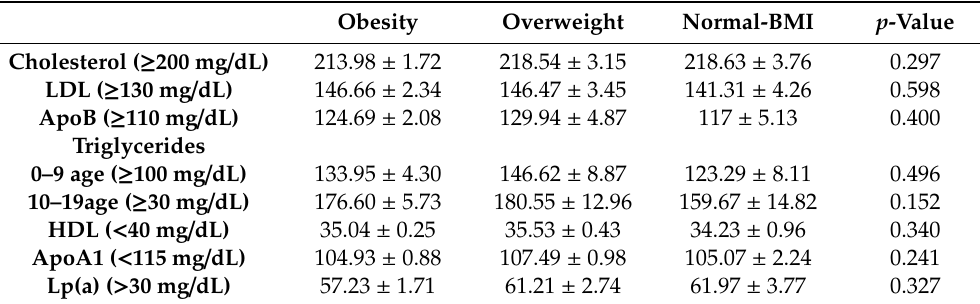
Table 4. Lipid profile indicative of dyslipidemia at